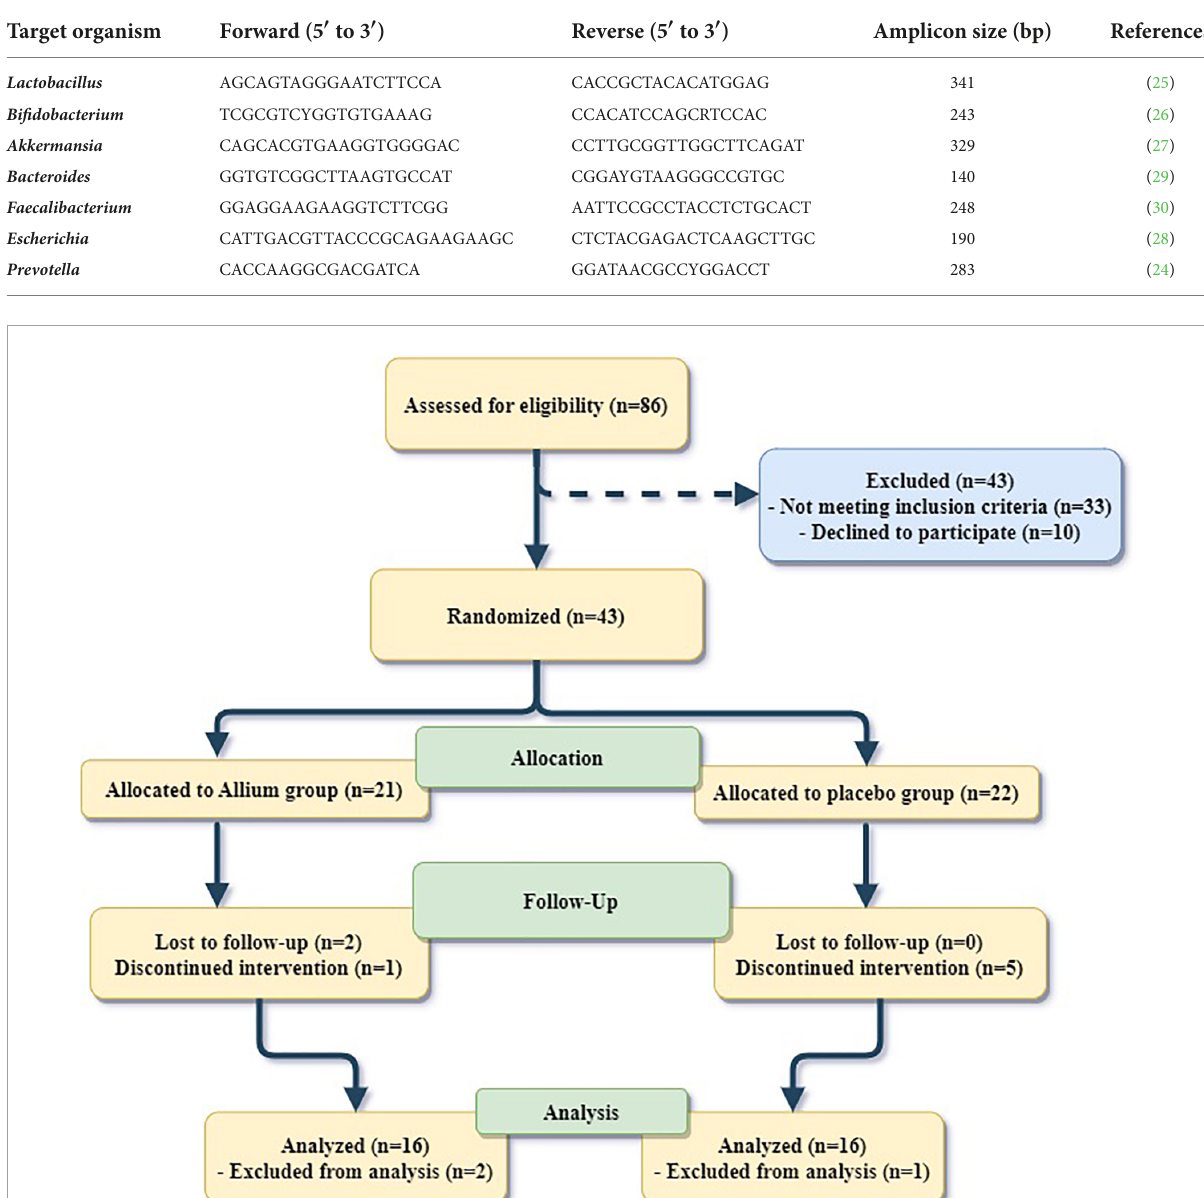
TABLE 1 16S rRNA gene specific primers for the studied bacterial genera.